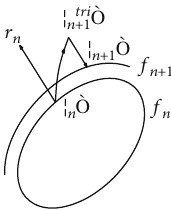
Figure 7: Graphic returns method of semi-implicit integration